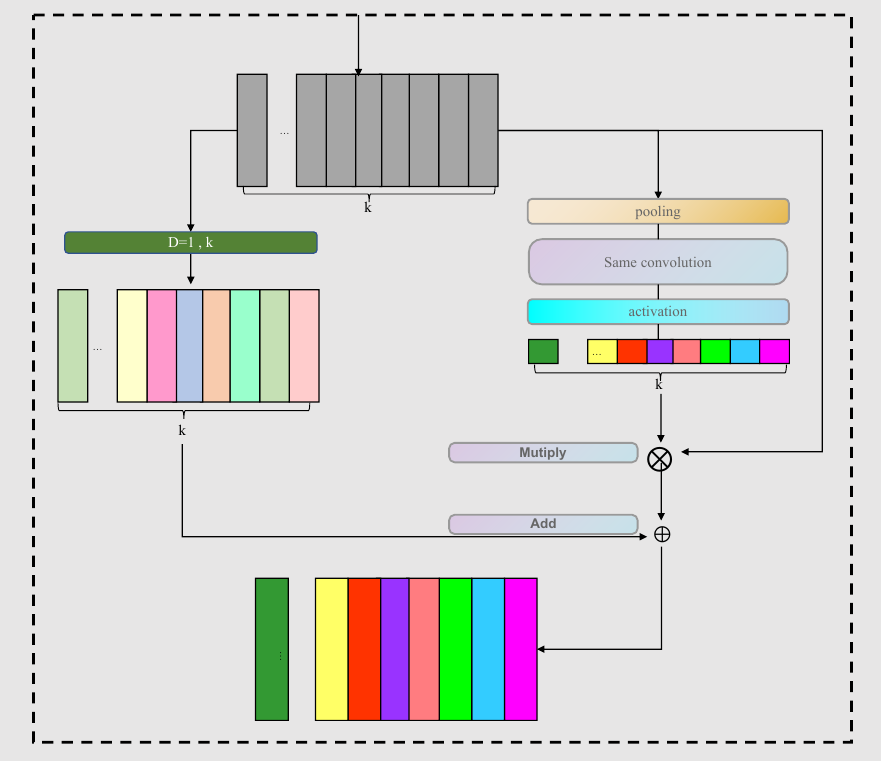
Figure 4. The construction of a ResNet-FCF